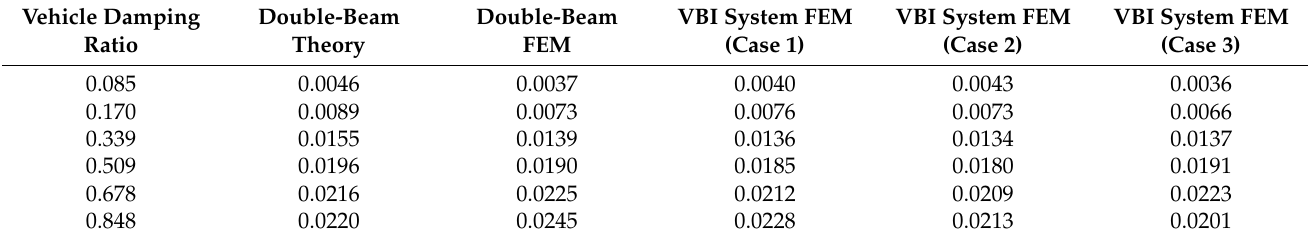
Table 1. Damping ratio calculation results for each